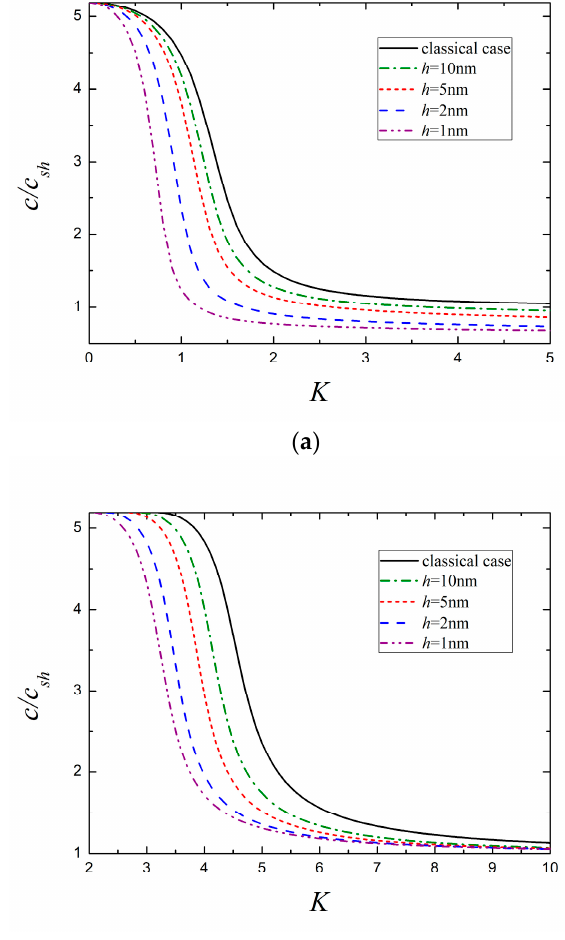
Figure 8. The lowest two modes for different nanofilm thickness. ( a ) The 1st mode and ( b ) the 2nd mode.